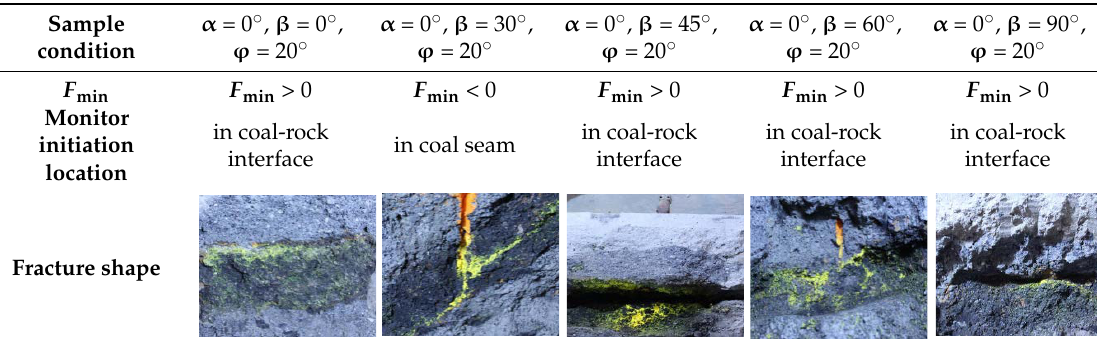
Table 3. Monitor results for initiation locations.